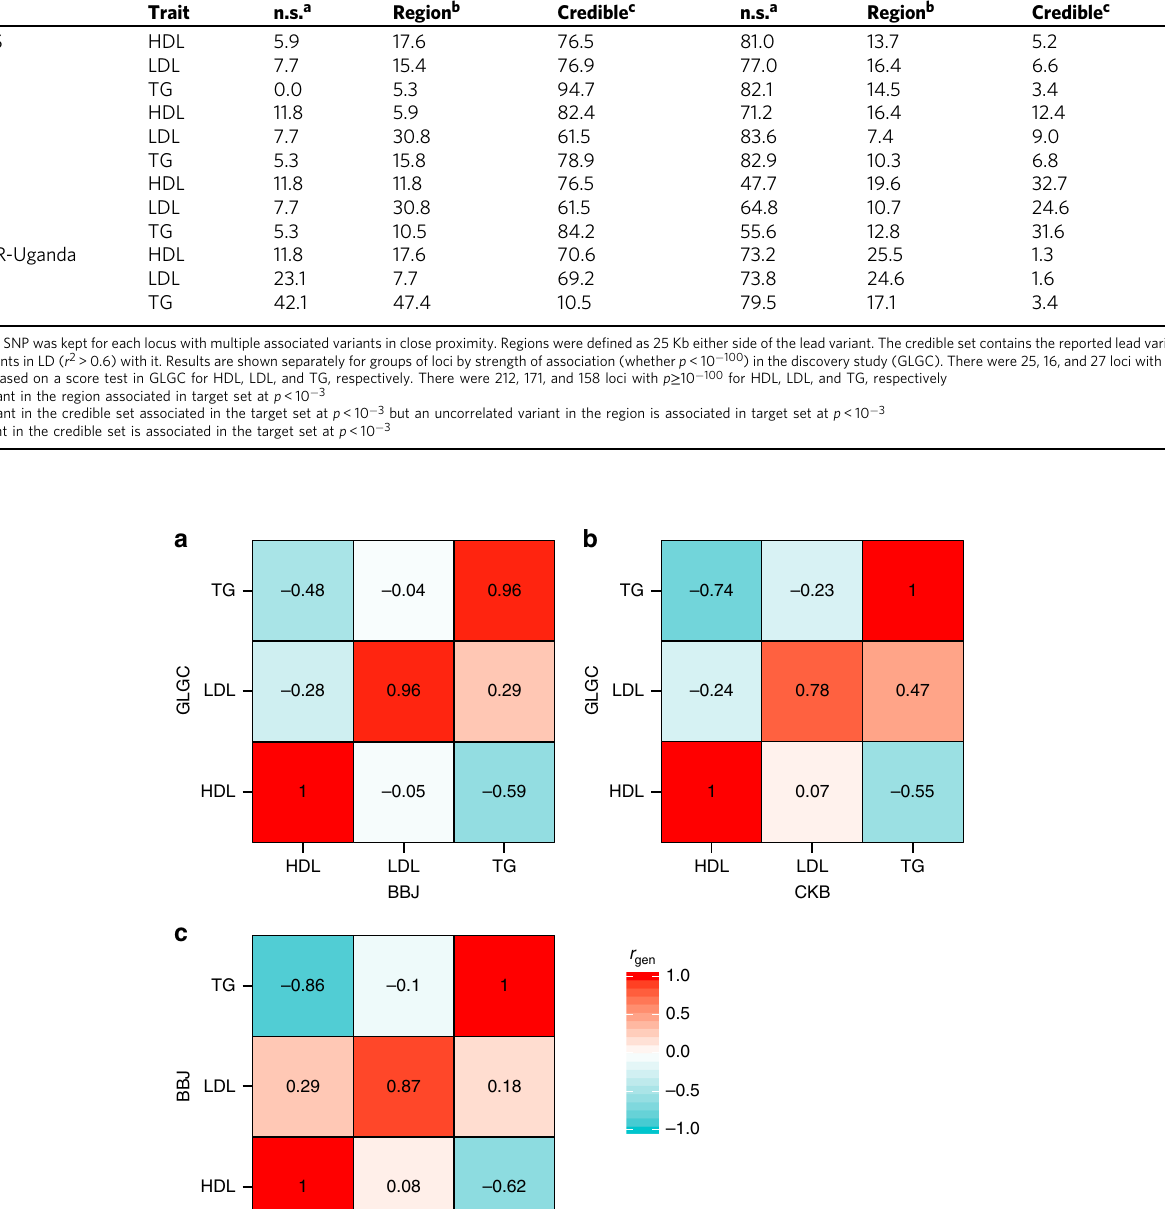
Table 1 Percentage of established lipid-associated loci with evidence of reproducibility in target studies P in